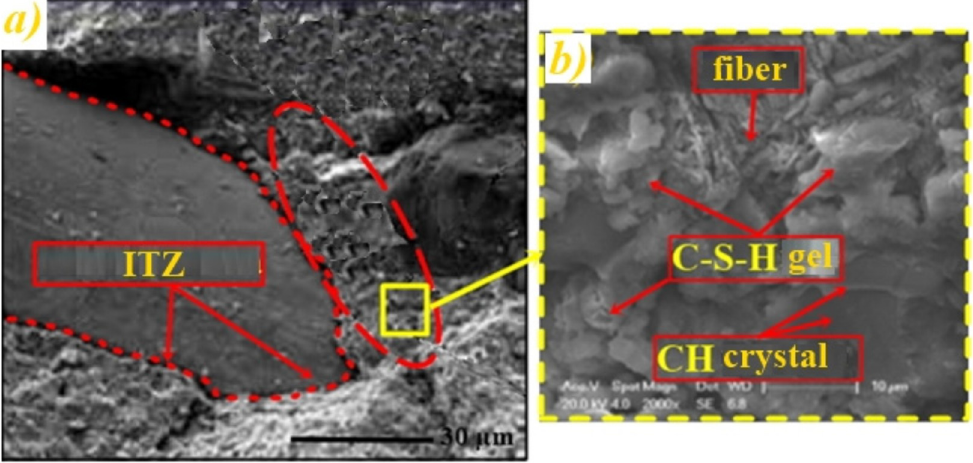
Figure 3. Interfacial transition zone [111]: ( a ) Wide SEM micrograph of the sample ( b ) Amplification of the SEM with effect of fiber bonding and the compaction of the interfacial transition zone (ITZ).